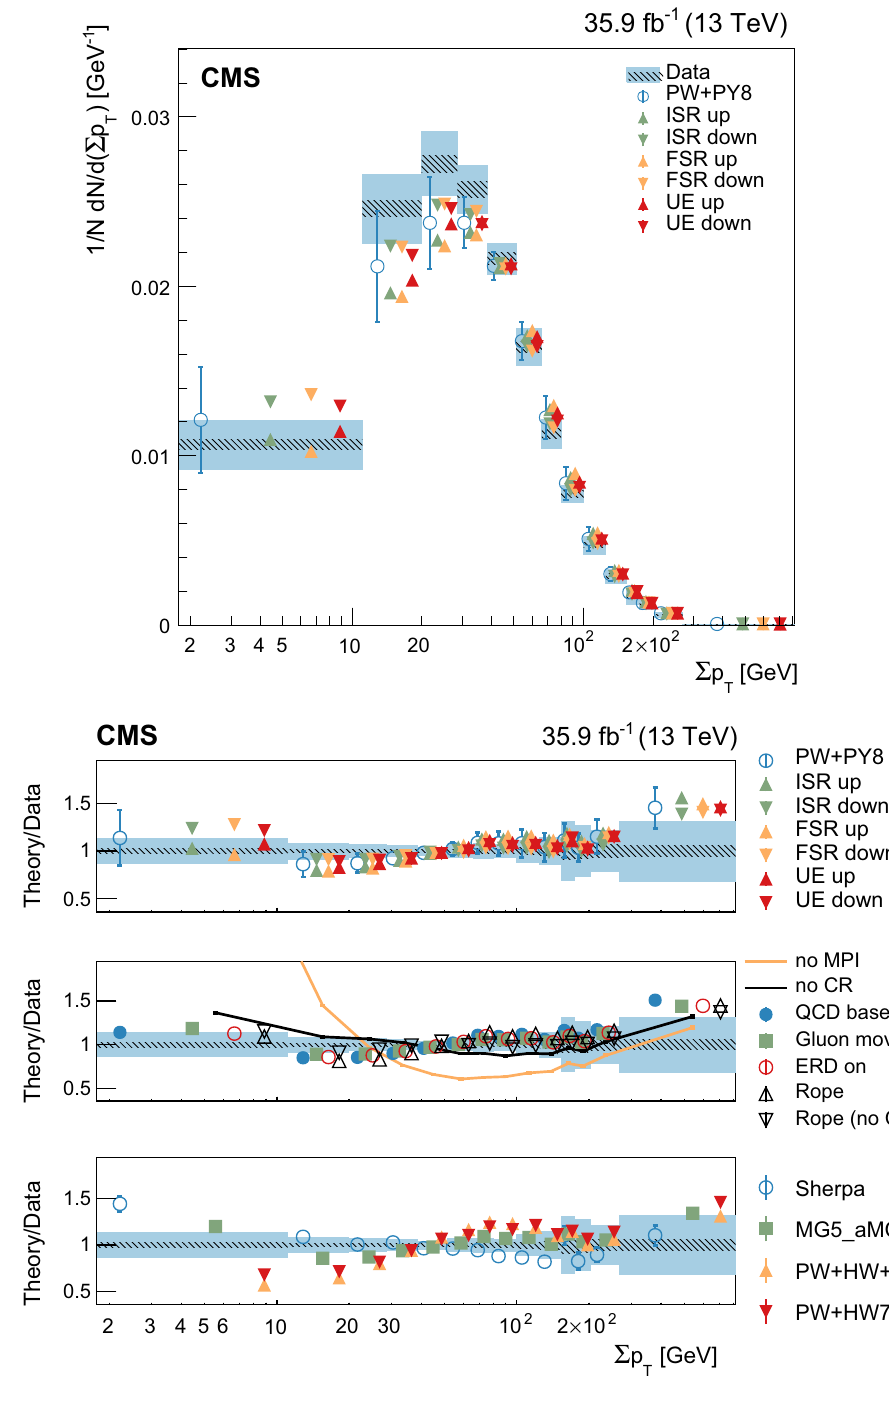
Fig. 5 Normalized differential cross section as function of (cid:2) p T , compared to the predictions of different models. The conventions of Fig. 4 are